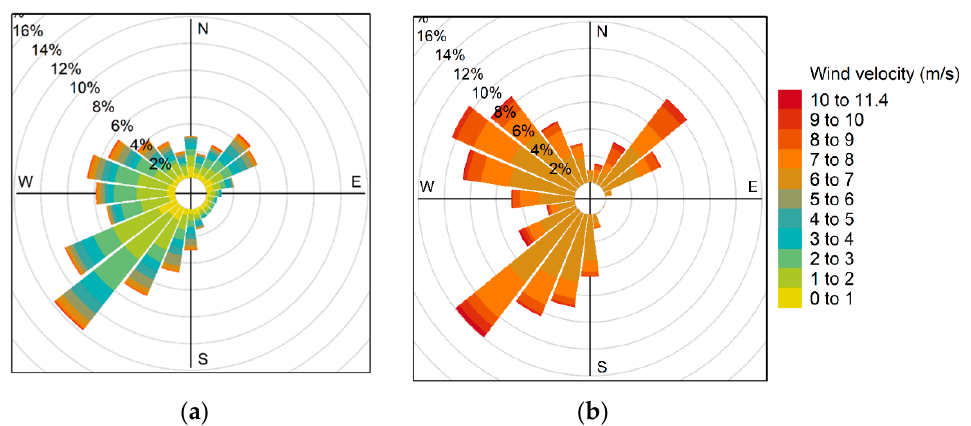
Figure 6. The wind roses from the wind data that were measured at an hour interval at the ARC climate station during the period of field monitoring of all the wind velocities ( a ) and the wind velocities above 6 m s − 1 ( b ).